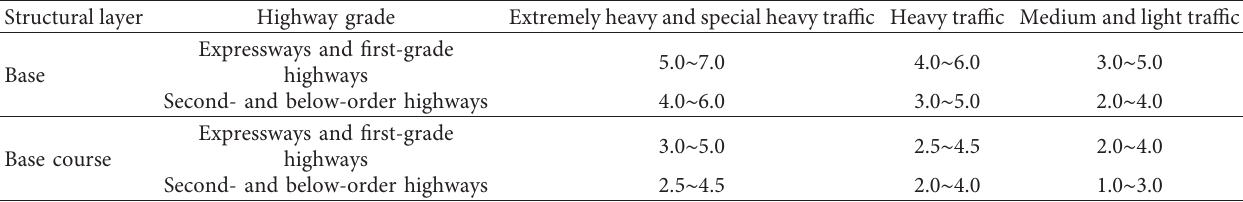
Table 7: Unconfined compressive strength standard of cement-stabilized material at seven days (MPa). Structural